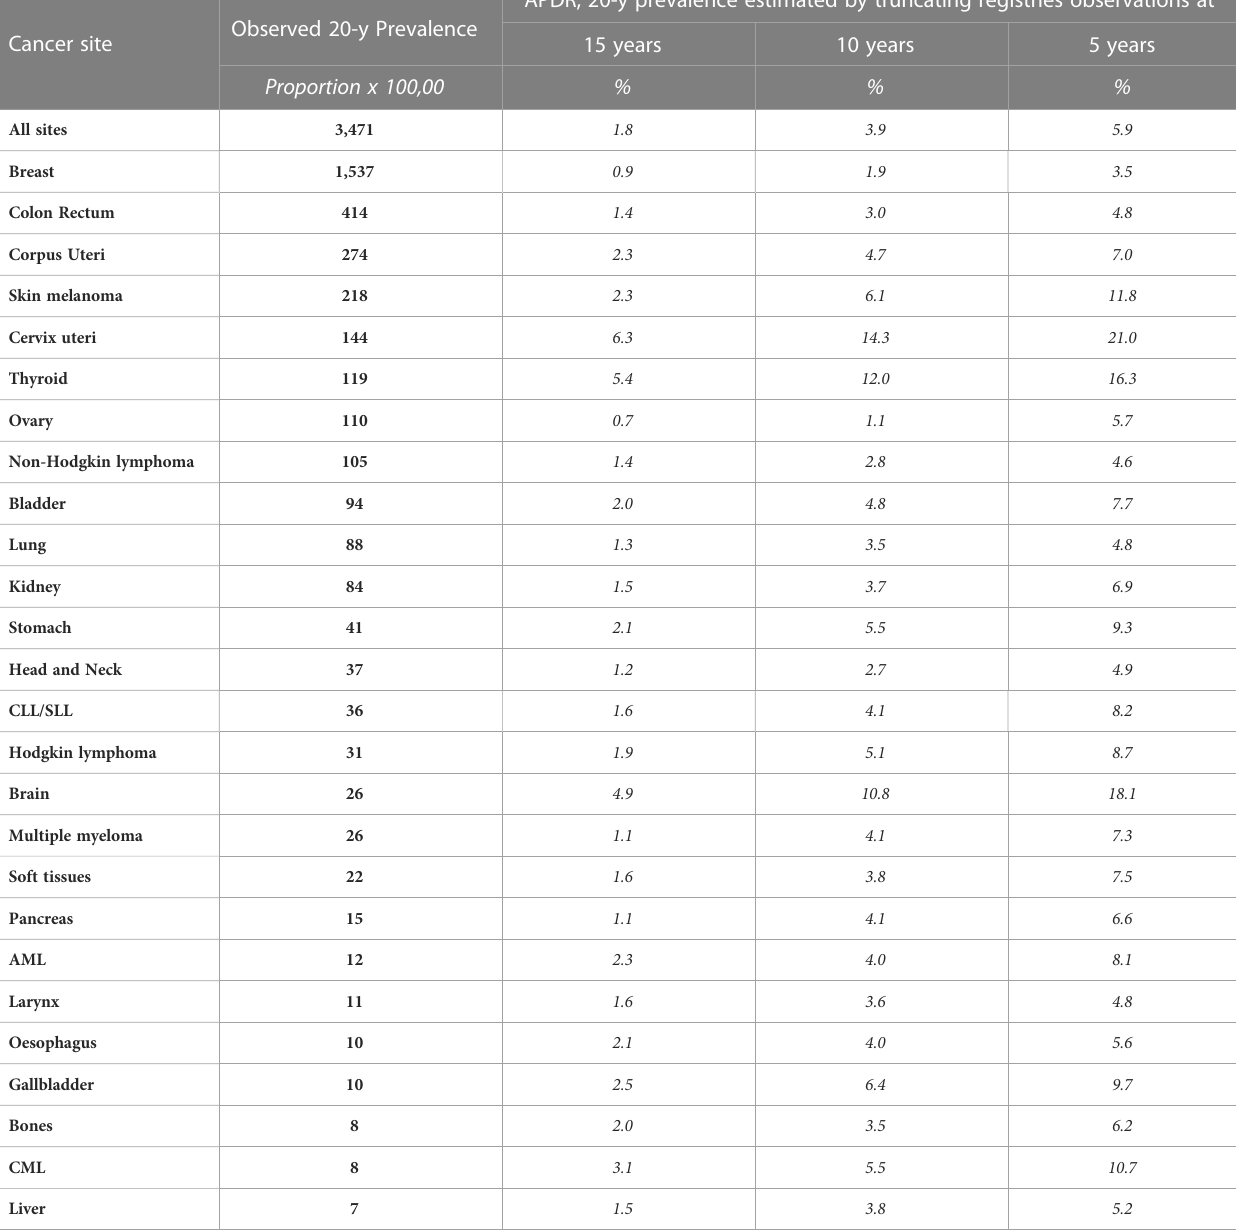
TABLE 2B Validation of European model-based R-index, women .